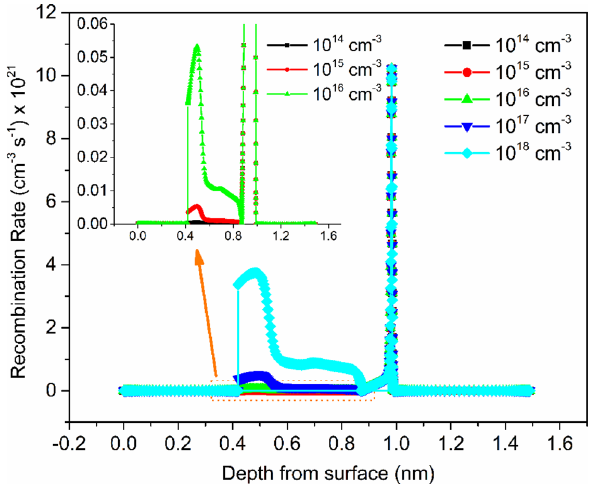
Figure 6. Variation of recombination rate with depth from surface for various defect density along with inset shows the close-up